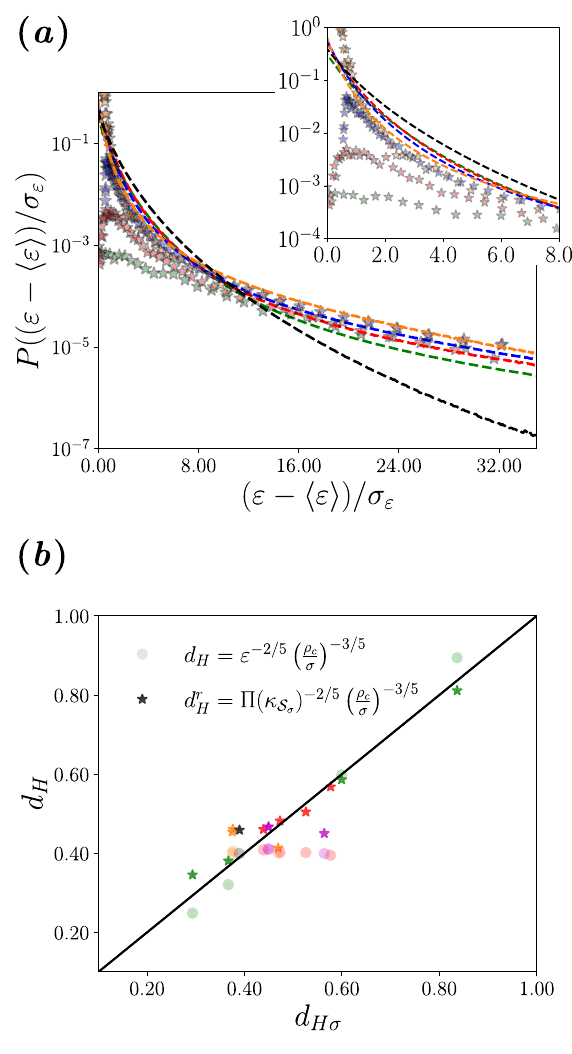
Fig. 4 Revisiting the KH scale, through scale-local energy fl uxes. a Probability-density-function for the normalized energy dissipation rate ε . Black dashed line is the reference single-phase case and colored dashed lines show data from multiphase simulations at different volume fractions α , i.e., 0.03 (green dashed line) 0.06 (red dashed line) 0.1 (blue dashed line) 0.5 (ocher dashed line) at constant large-scale Weber number (see Methods) We L ¼ 42 : 6 and μ d / μ c = 1. The stars indicate the values of epsilon computed from the DSD where ε ∝ d − 5/2 and P ( ε ) ∝ d 13/2 N ( d ) and their color indicates the case (same coloring as dashed lines). The inset shows the details for the PDF at low ε . b Comparison among the different methods used to compute the Hinze scale, i.e., the original formulation d H , and the proposed approach d H , obtained as the scale at which S σ ¼ 0. For σ d H , we show two formulations, namely the original formulation proposed in 19 (circles), and the novel interpretation d r H (stars). The computation of d r H Þ , with κ ¼ 2 π = d uses the wavenumber-local non-linear fl uxes at Π ð κ S S σ H σ . σ The pre-factor 0.8 is used in the expression of d r H , to account for fi nite Re λ effects. The black diagonal line shows where d r H ¼ d H , highlighting the σ improvement provided by the novel interpretation of the Hinze scale. Colors indicates different α (red) at We L = 42.6 and μ d / μ c = 1; different We μ μ = 1 and α = 0.03; different μ μ α = 0.1 d / c d / c (purple) at L (green) at and We L = 42.6, and different μ d / μ c (yellow) at α = 0.03 and We L = 42.6.